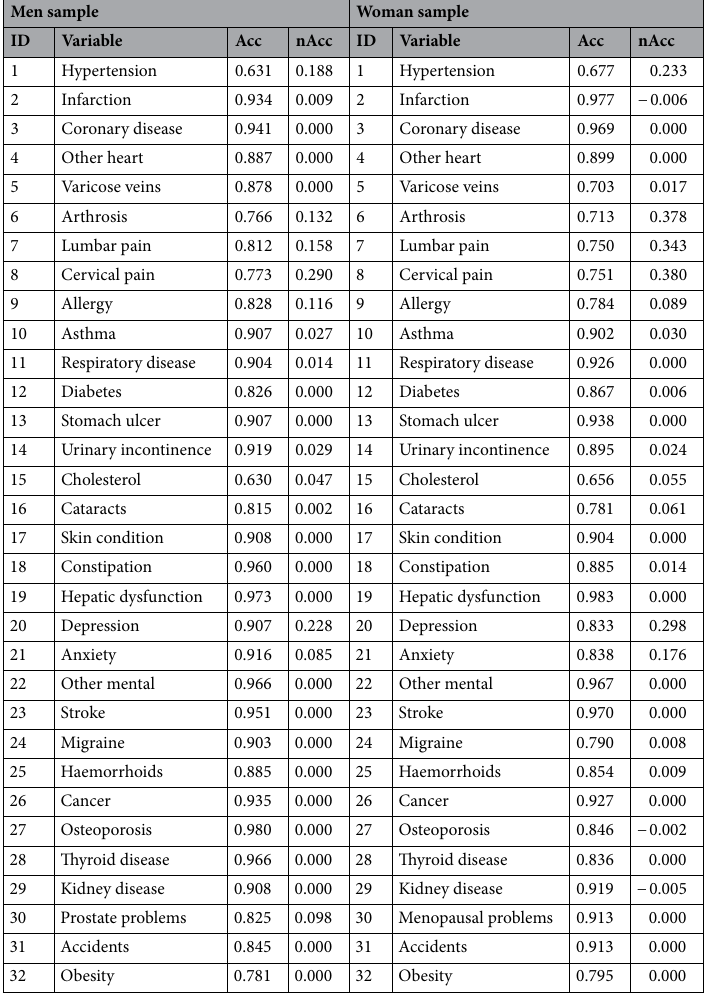
Table 1. Comparison of the classification accuracy of the implemented MGMs (Acc: Accuracy; nAcc: Normalised